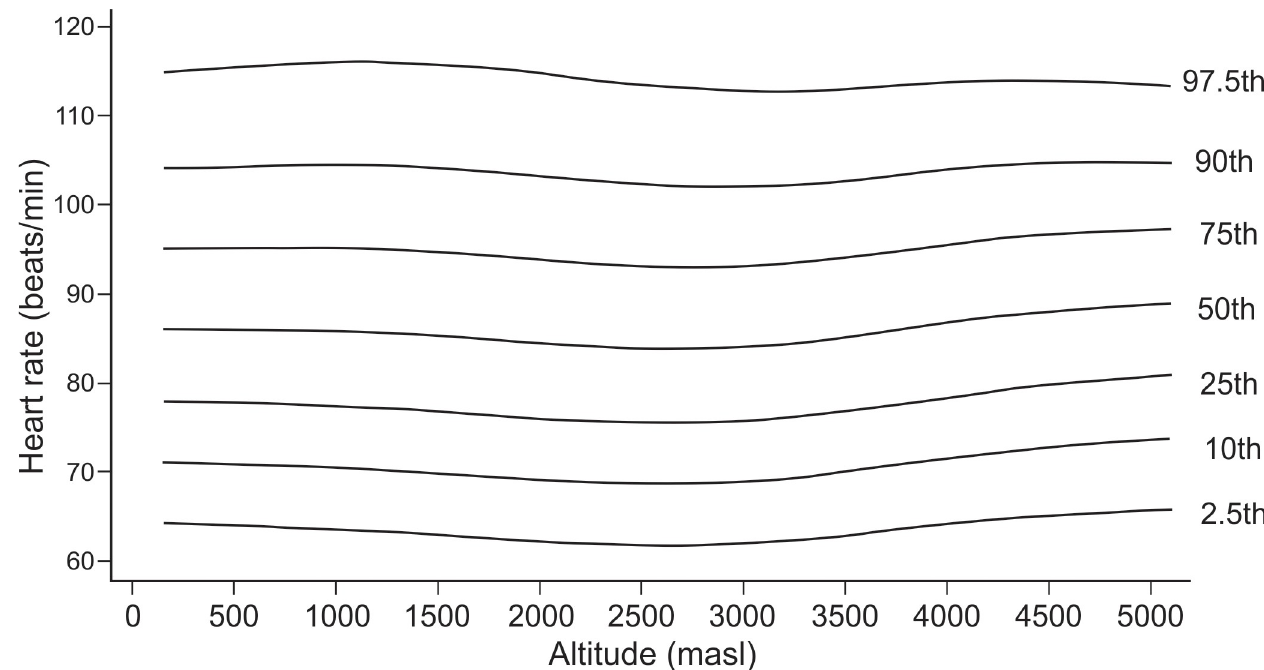
Fig 3. Heart rate at rest according to altitude of residence in Peruvian adults of 18–50 years of age.